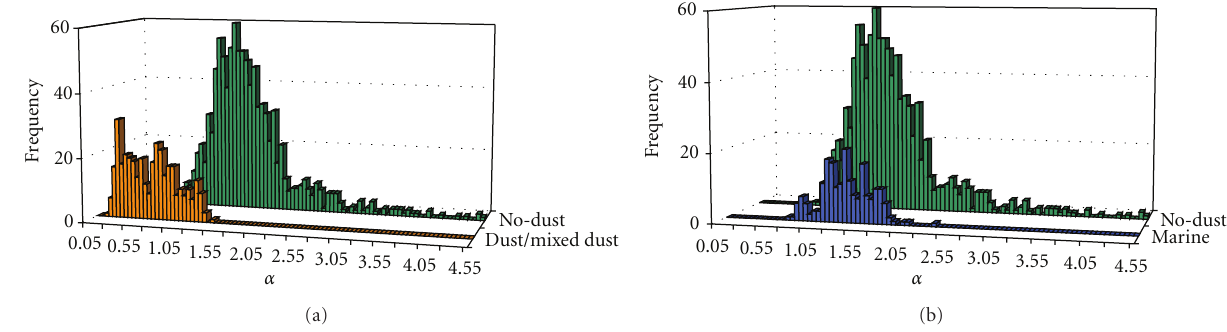
Figure 2: Histograms of alpha parameter (a) comparing dust/mixed dust and no-dust data and (b) comparing no-dust and marine data.